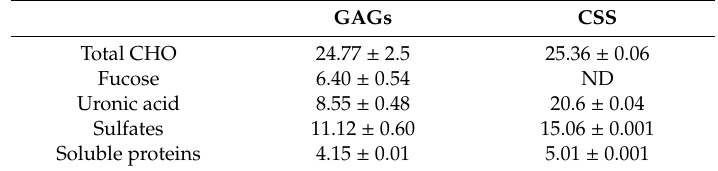
Table 1. Chemical composition ( w / w , %) of GAGs extracted from Isostichopus badionotus from the Yucatan Peninsula compared to a non-fucosylated chondroitin sulfate from shark cartilage (CSS).